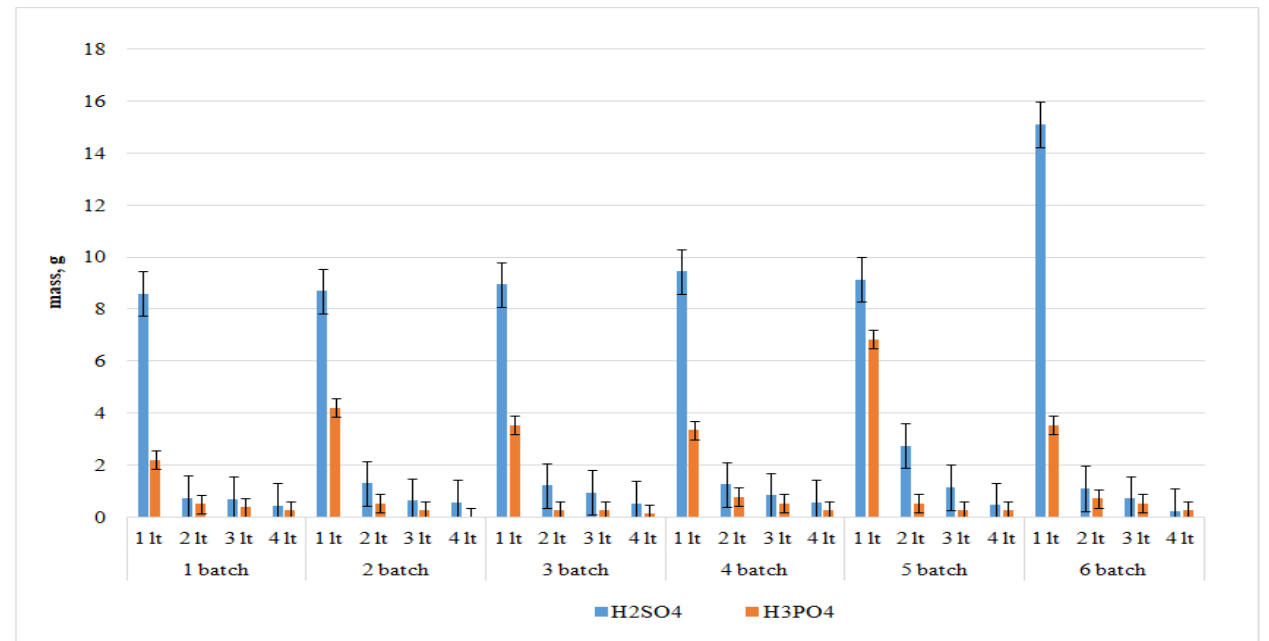
Figure 3. Mass of sulfuric and phosphoric acids in water after a series of phosphogypsum washing with water.